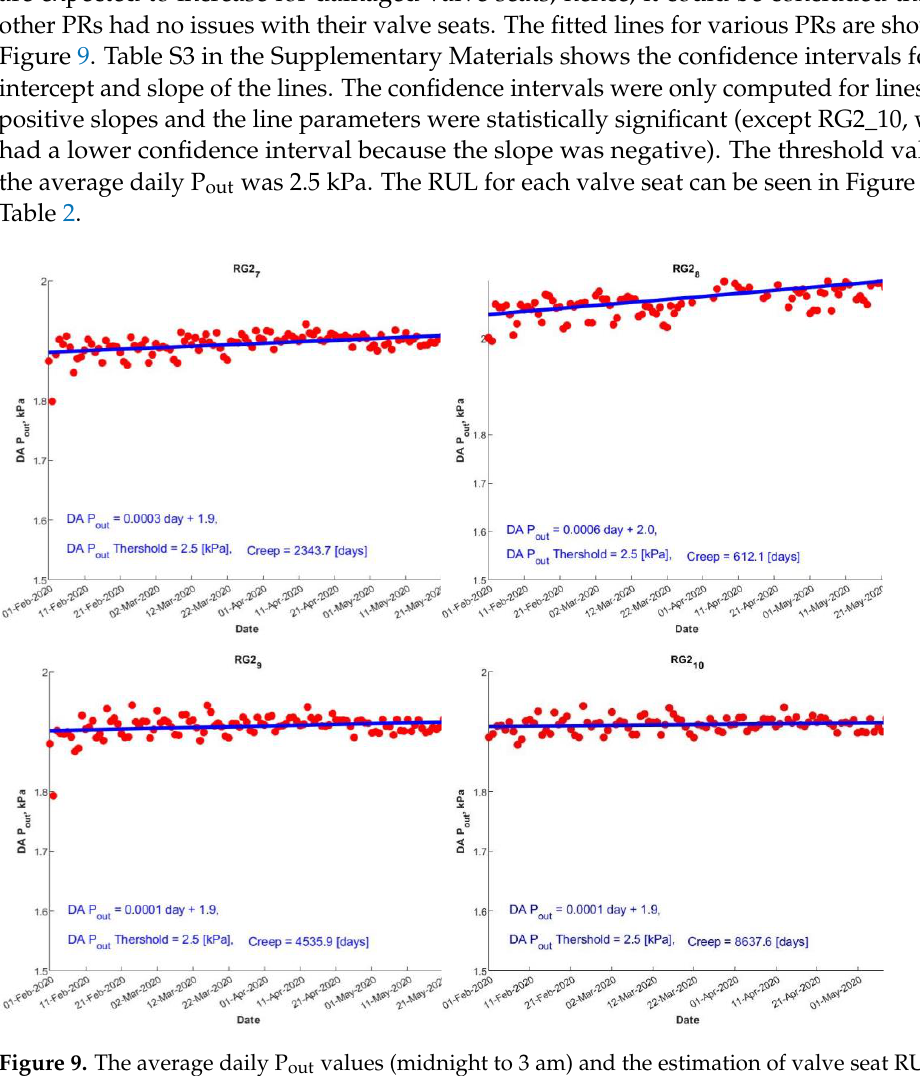
Figure 9. The average daily P out values (midnight to 3 am) and the estimation of valve seat RUL. No creep effect was observed for the other PRs.